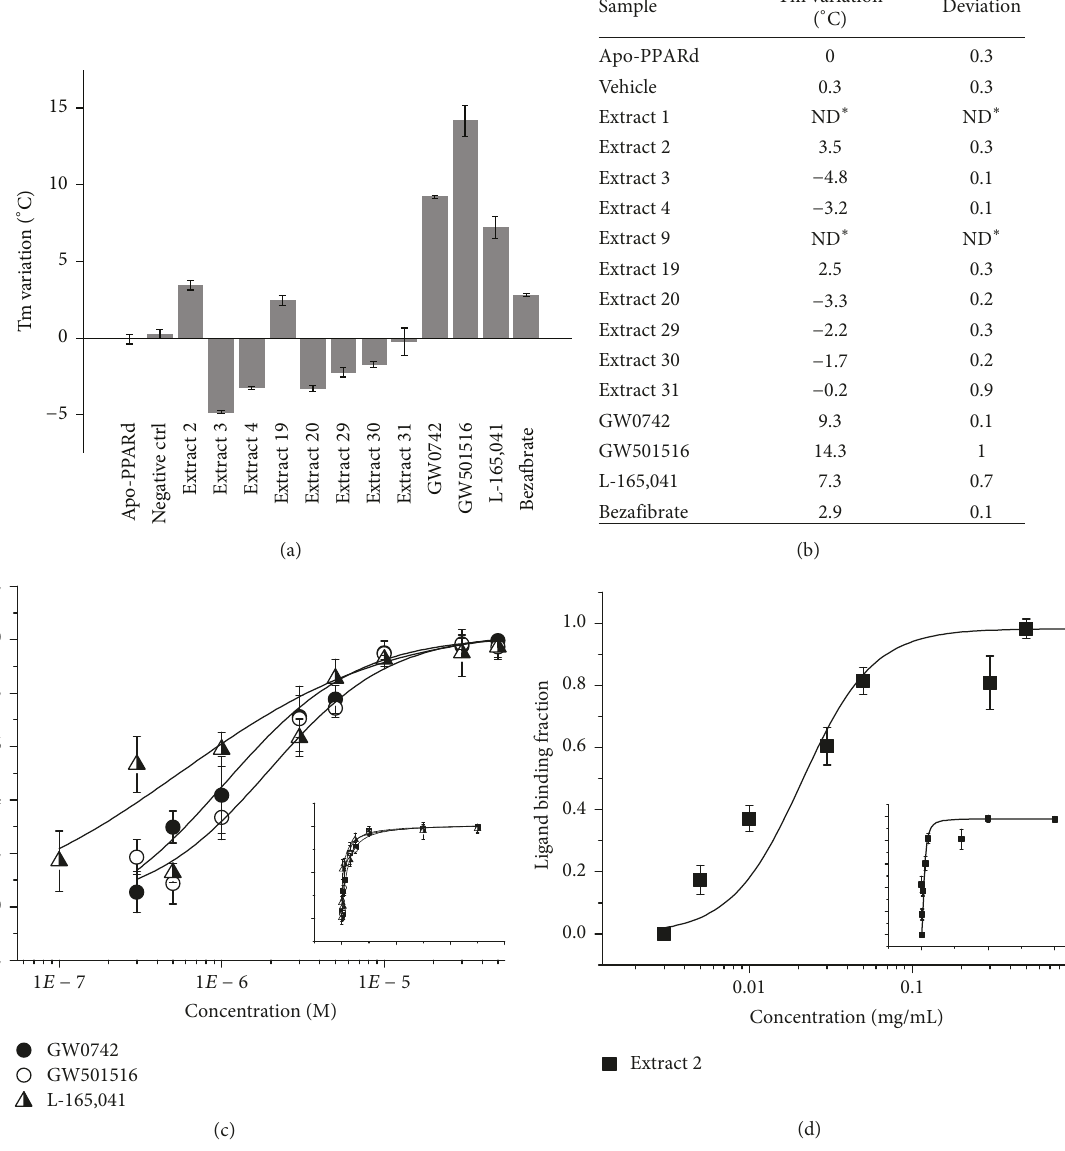
Figure5:ValidationassaysofPPARß/ 𝛿 ligandscreening.(a)Thermalshiftassayofhitcandidates.TenmicromolarPPARß/ 𝛿 withcommercial agonists (GW0742, GW501516, L-165,041, and Bezafibrate) at 30 𝜇 M or extracts at 0.14mg/mL. The vehicle is DMSO. Experiments were performed in triplicate. Data are the mean ± SD. (b) Table with 𝑇 𝑚 variation and standard deviation for the extracts/compounds from the thermal shift. The experiment was performed in triplicate. ND ∗ : not defined. It is possible to verify that two possible hit candidates stabilized the receptor structure by more than 2.5 ∘ C, indicating direct binding to the receptor. (c)-(d) Dissociation curves for PPARß/ 𝛿 ligands and hit candidates. Normalized fluorescence intensity at the emission maximum (480 nm) versus the ligand/fraction concentration, adjusted by the Hill1 approach with OriginPro 8.0. Dissociation curves for the commercial agonists varied from 10 −7 to 10 −5 𝜇 M. In the dissociation curve, the concentration varied from 0.003 to 1mg/mL. Data are the mean ± SD ( 𝑛 = 3 independent